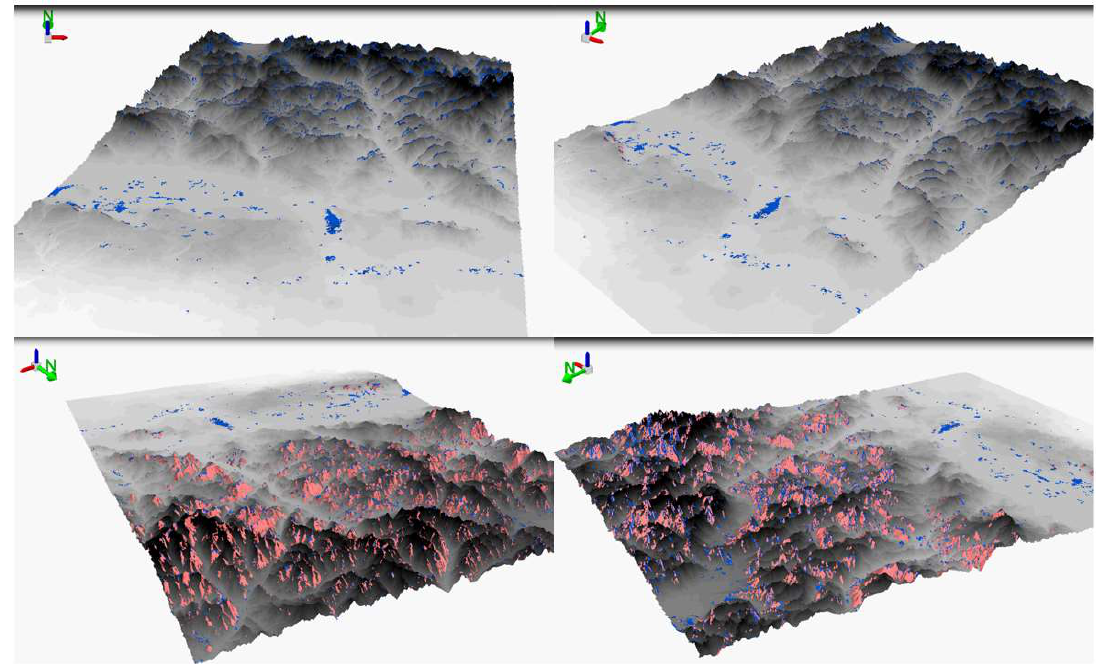
Figure 9. 3D animation to show the distribution of false classification identified by our algorithm. (part of southeastern Idaho; pink indicates area being removed by the algorithm, blue indicates remaining flood area in the dataset).